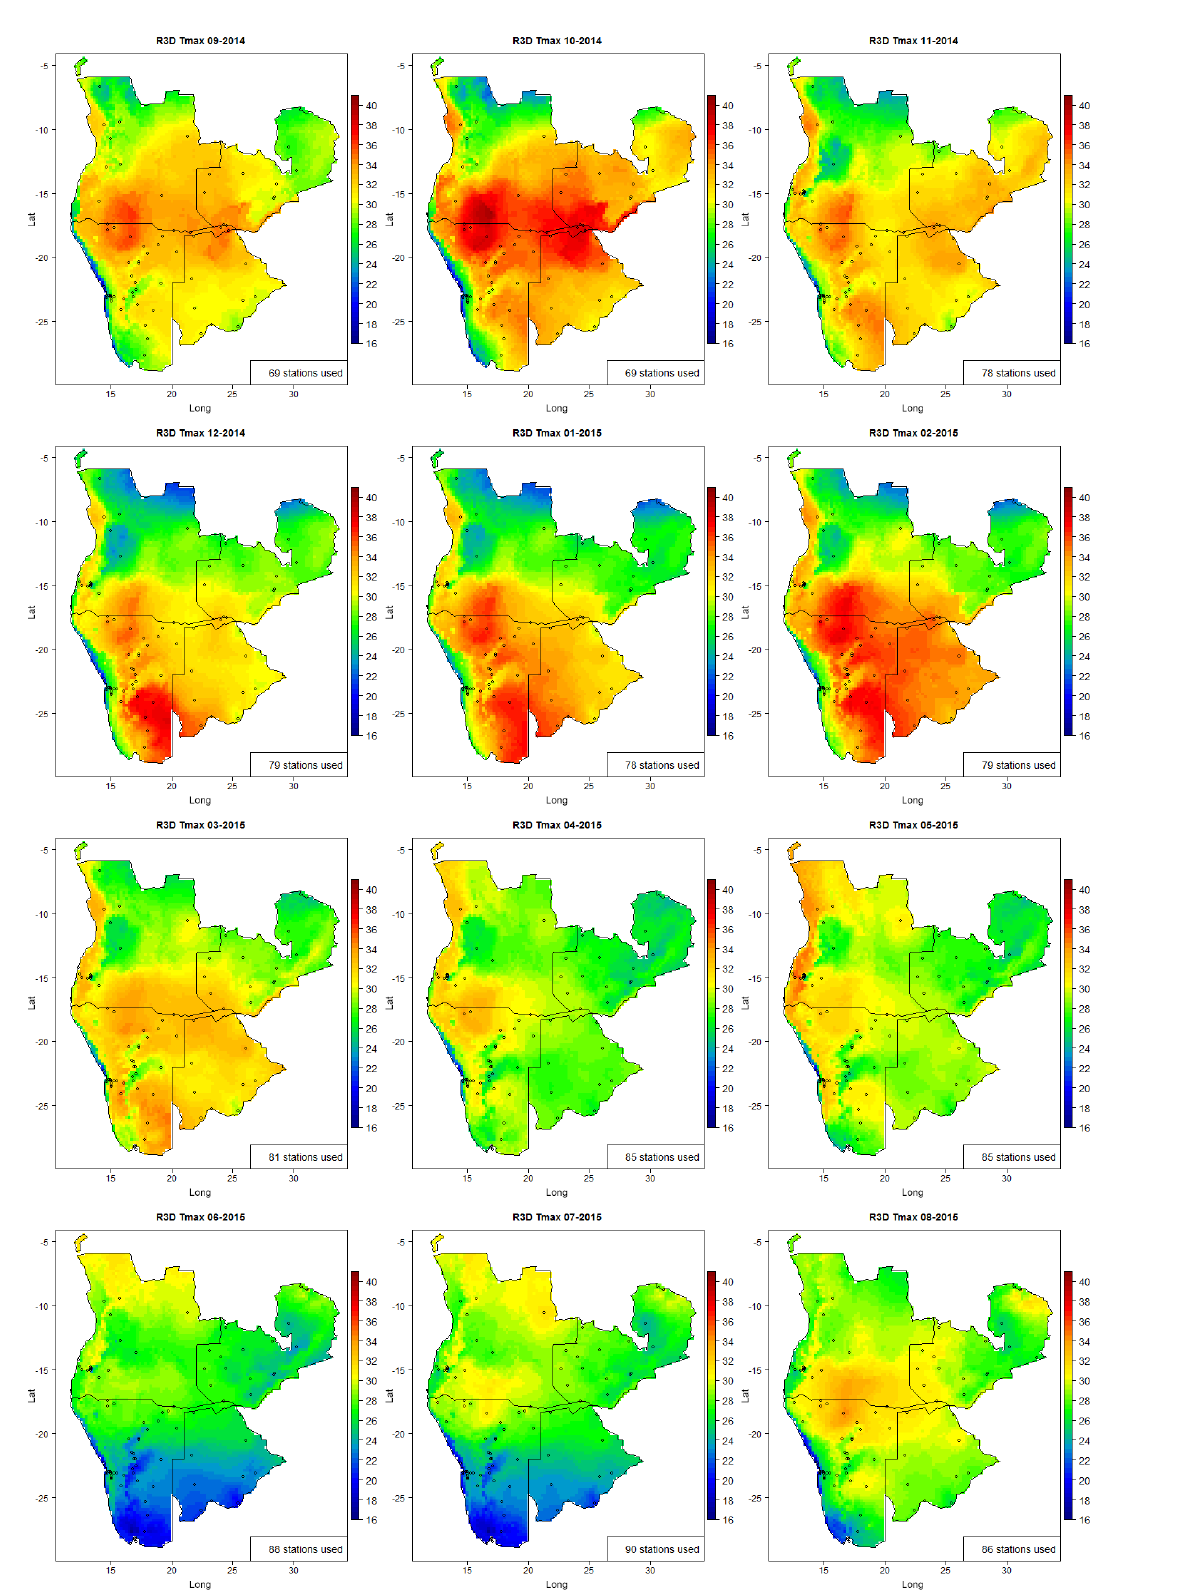
Figure 8. Maximum temperature maps on basis of three dimensional inverse distance weighting method from September 2014 until Au- gust 2015. Unit: ◦